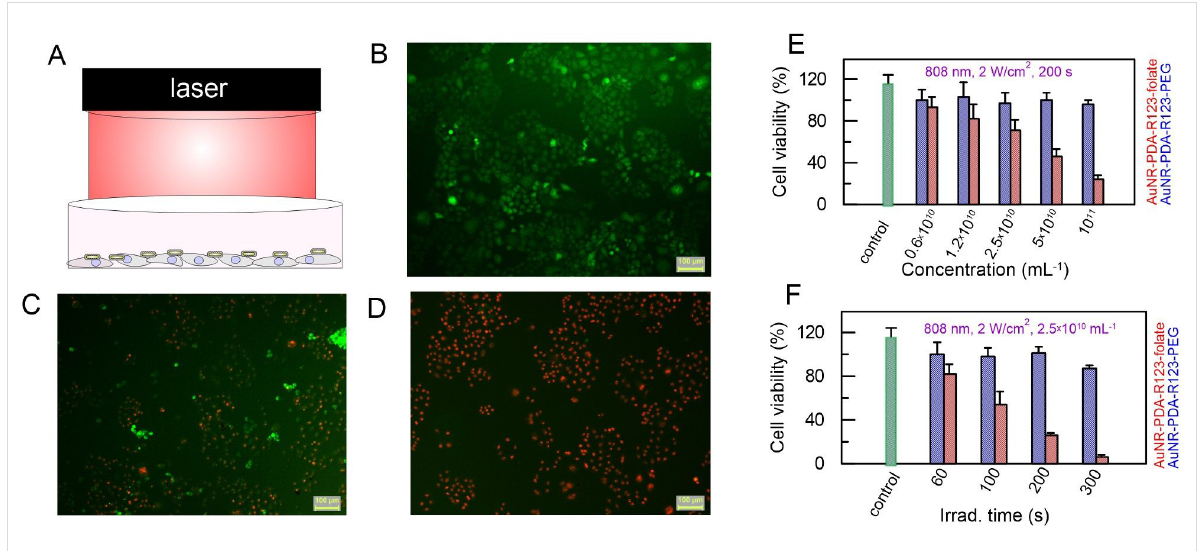
Figure 4: Photothermal therapy of Hela cells in vitro. (A) Scheme of Hela cells irradiation; (B) fluorescence images of FDA/PI co-stained (live cells are green, dead cells are red) samples after targeted photothermal ablation: control, non-irradiated cells; cells incubated with 5 × 10 10 mL − 1 AuNR-PDA- R123-folate after (C) 60 s and (D) 300 s of 808 nm irradiation at 2 W/cm 2 . The scale bar is 100 μ m. (E) Cell viabilities estimated through standard resazurin assay after photothermal ablation using AuNR-PDA-R123-folate (red bars) and AuNR-PDA-R123-PEG (blue bars) at different concentra- tions, other parameters were 808 nm laser, 2 W/cm 2 , 200 s. (F) Cell viabilities after photothermal ablation using AuNR-PDA-R123-folate (red bars) and AuNR-PDA-R123-PEG (blue bars) at different irradiation times, other parameters were 808 nm laser, 2 W/cm 2 , nanoparticles concentration 2.5 × 10 10 mL − 1